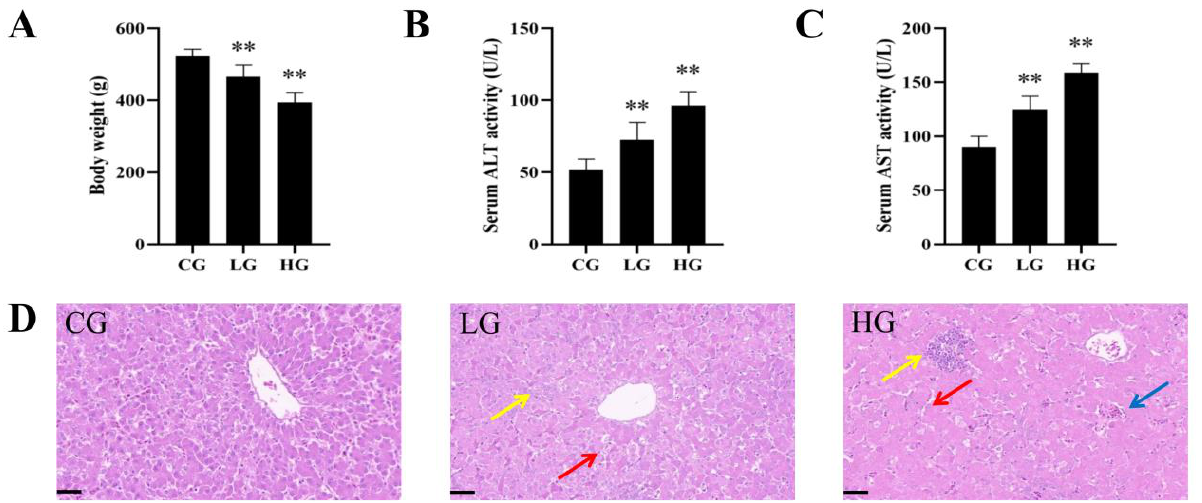
Figure 2. AFB 1 exposure caused liver damage in ducks. ( A ) Body weight ( n = 6). ( B ) Serum ALT activity ( n = 6). ( C ) Serum AST activity ( n = 6). ( D ) Representative images of liver HE staining (red arrow: disordered hepatic cords; yellow arrow: infiltrated inflammatory cells; blue arrow: hepatocyte disintegration). Scale bar: 50 μm. ** p < 0.01 vs. the CG.